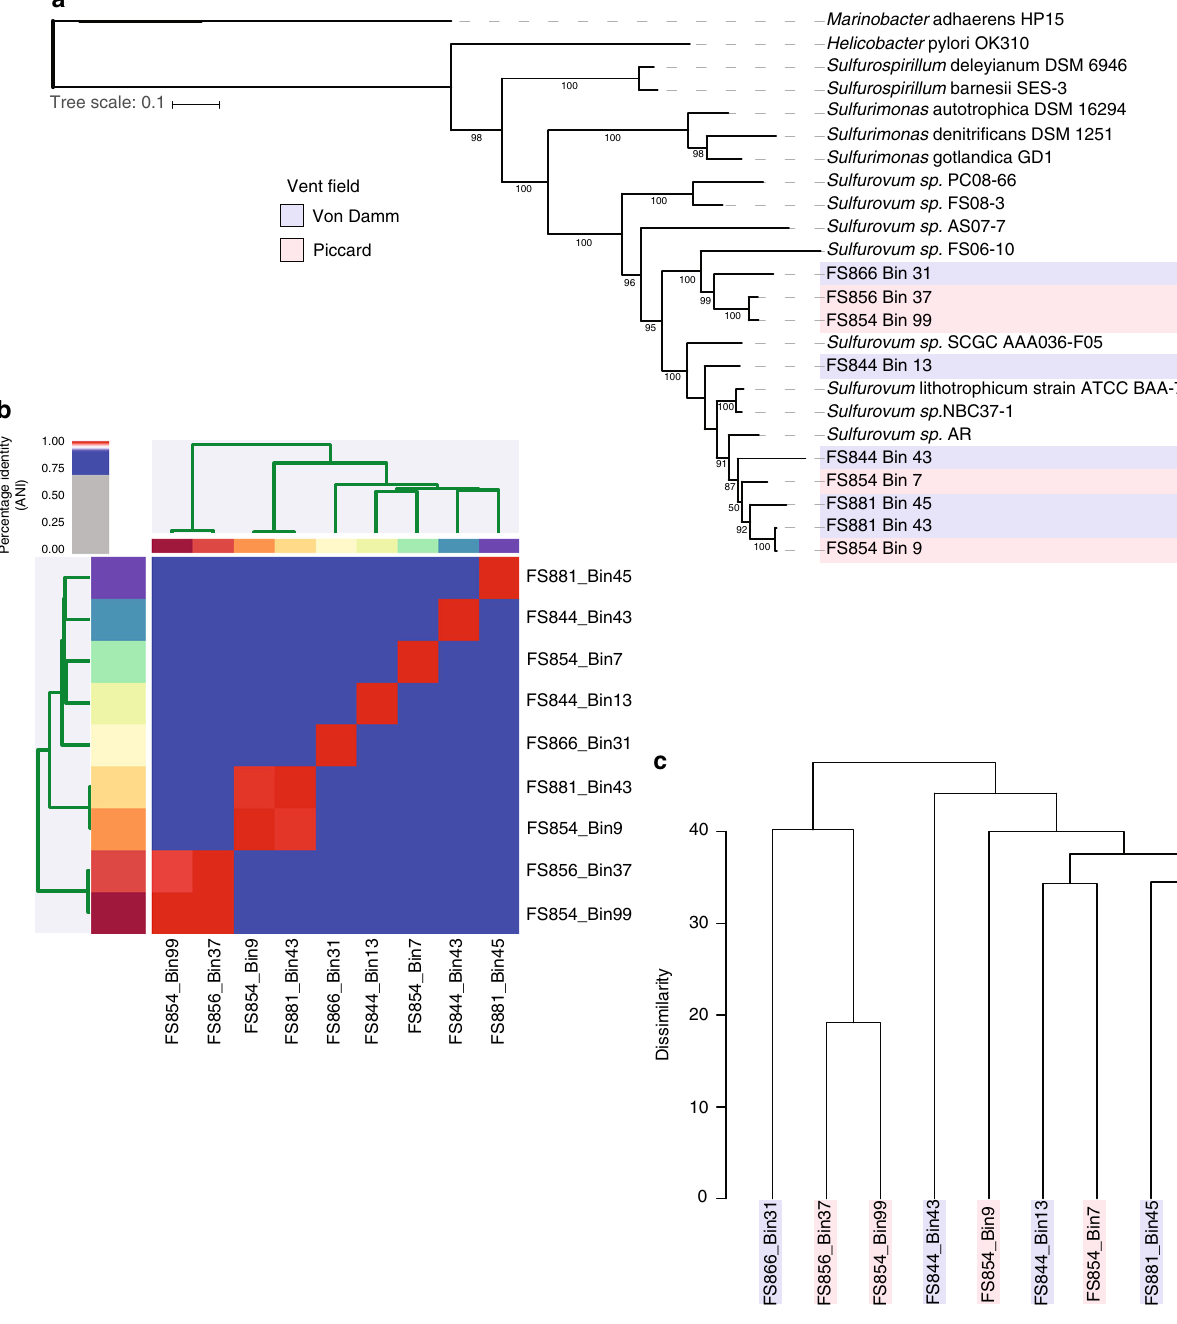
Fig. 3 Relationships among Sulfurovum MAGs according to universal gene phylogeny, ANI, and gene content. a Phylogenetic tree based on concatenated single-copy universal marker proteins. Sulfurovum MAGs are indicated in light red (Piccard) and light blue (Von Damm); reference genomes have no color designation. b Heatmap and cluster dendrogram grouping MAGs according to ANI. c Hierarchical clustering dendrogram based the presence and absence of ORF clusters in MAGs. MAGs are colored according to vent fi eld; red is Piccard, blue is Von